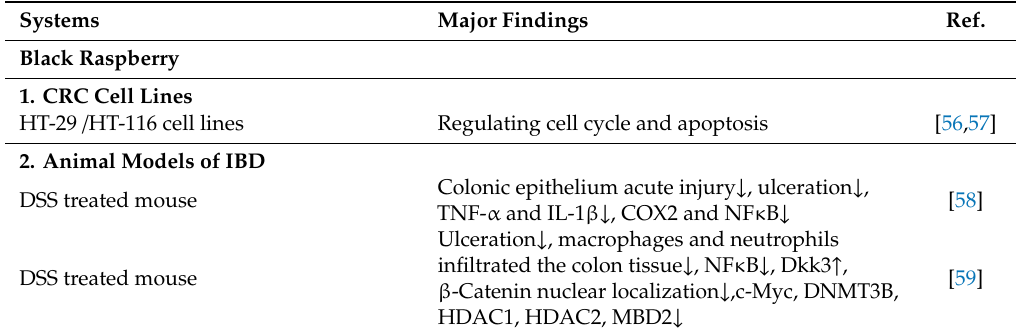
Table 1. Preventive e ff ects of black raspberry and strawberry on Inflammatory Bowel Disease (IBD) and